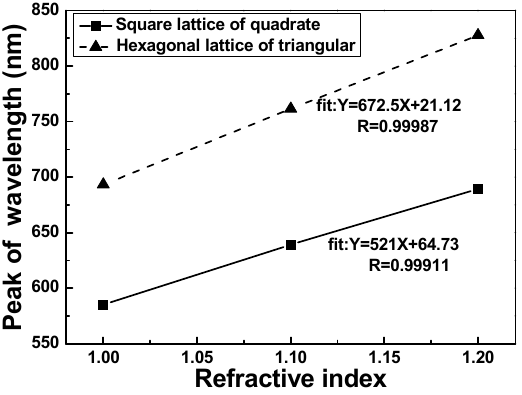
Figure 5. Refractive index sensitivity curves of nanoparticle arrays for different monome shape. Table 1. Refractive index sensitivity (RIS), width at half maximum (FWHM), and figure of merit (FOM) using for hybrid Au–Ag nanoparticle arrays under two different structures. Feature/Characteristic Hexagonal Array Tetragonal Array RIS (nm/RIU)